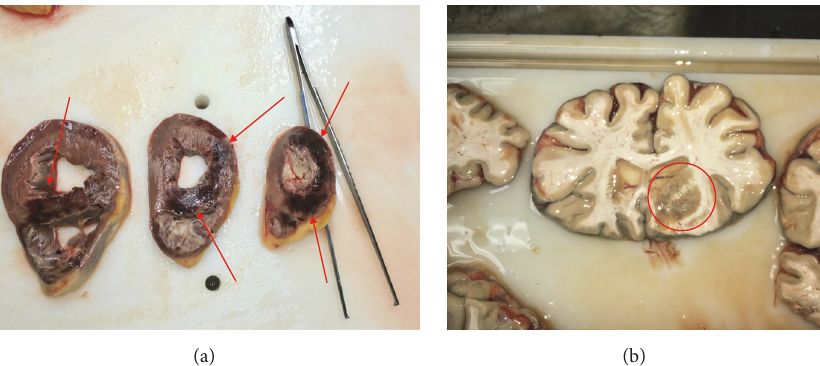
Figure 5: (a) Acute myocardial infarction involving extensively the right ventricle and the septum; (b) acute cerebral infarction downstream the arteries obstructed by the GE.